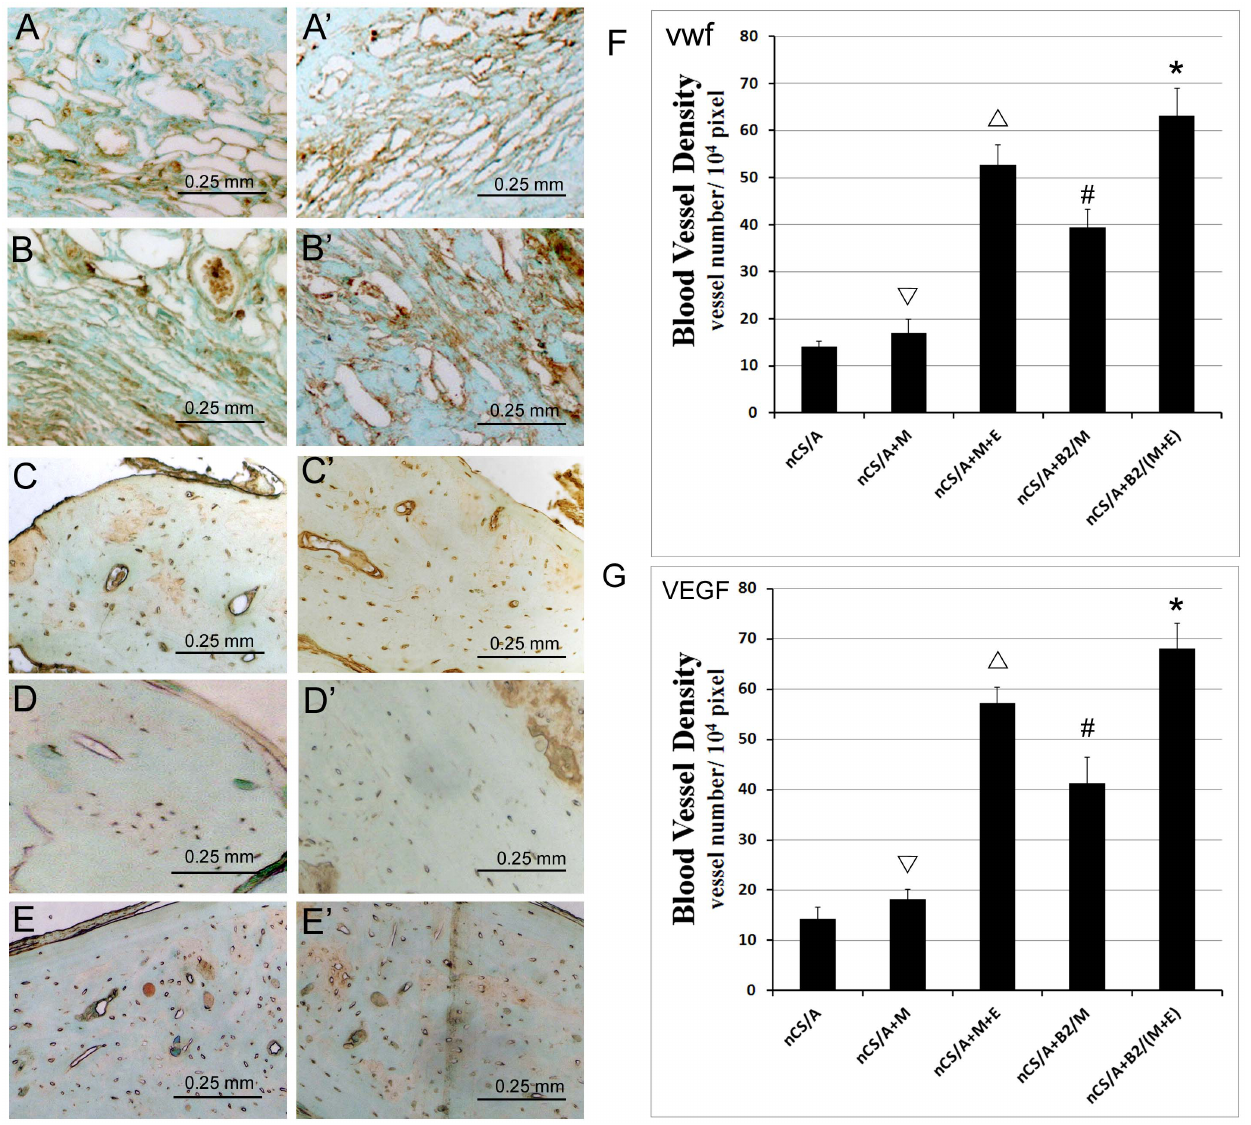
Figure 6. Blood vessel growth in rat critical-sized calvarial defect model. (A-E) Immunostaining of endothelial cell marker - vWF. (A’-E’) Immunostaining of VEGF. (A, A’): nCS/A; (B, B’): nCS/A + M; (C, C’): nCS/A + M + E; (D, D’): nCS/A + B2/M; (E, E’): nCS/A + B2/(M + E). (F) Quantitative analysis of blood vessel density from (A-E). (G) Quantitative analysis of blood vessel density from (A’-E’). N =5, bar=0.25 mm. * p , 0.05: nCS/A + B2/(M + E) vs. each of the other four groups. # p , 0.05: nCS/A + M + E vs. nCS/A + B2/M or nCS/A + M or nCS; n p , 0.05: nCS/A + B2/M vs. nCS/A + M or nCS/A only; , p , 0.05: nCS/A + M vs. nCS/A.